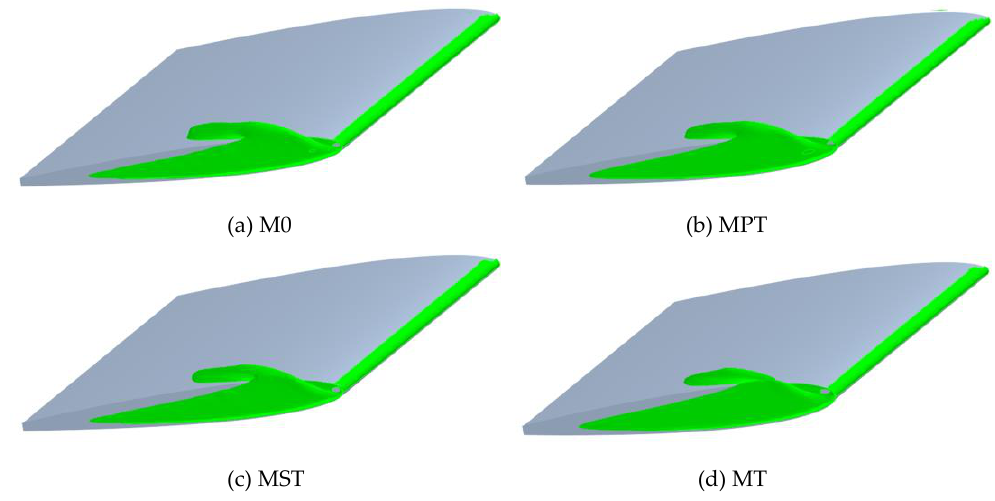
Figure 12. Proudman AP on five cut-planes.